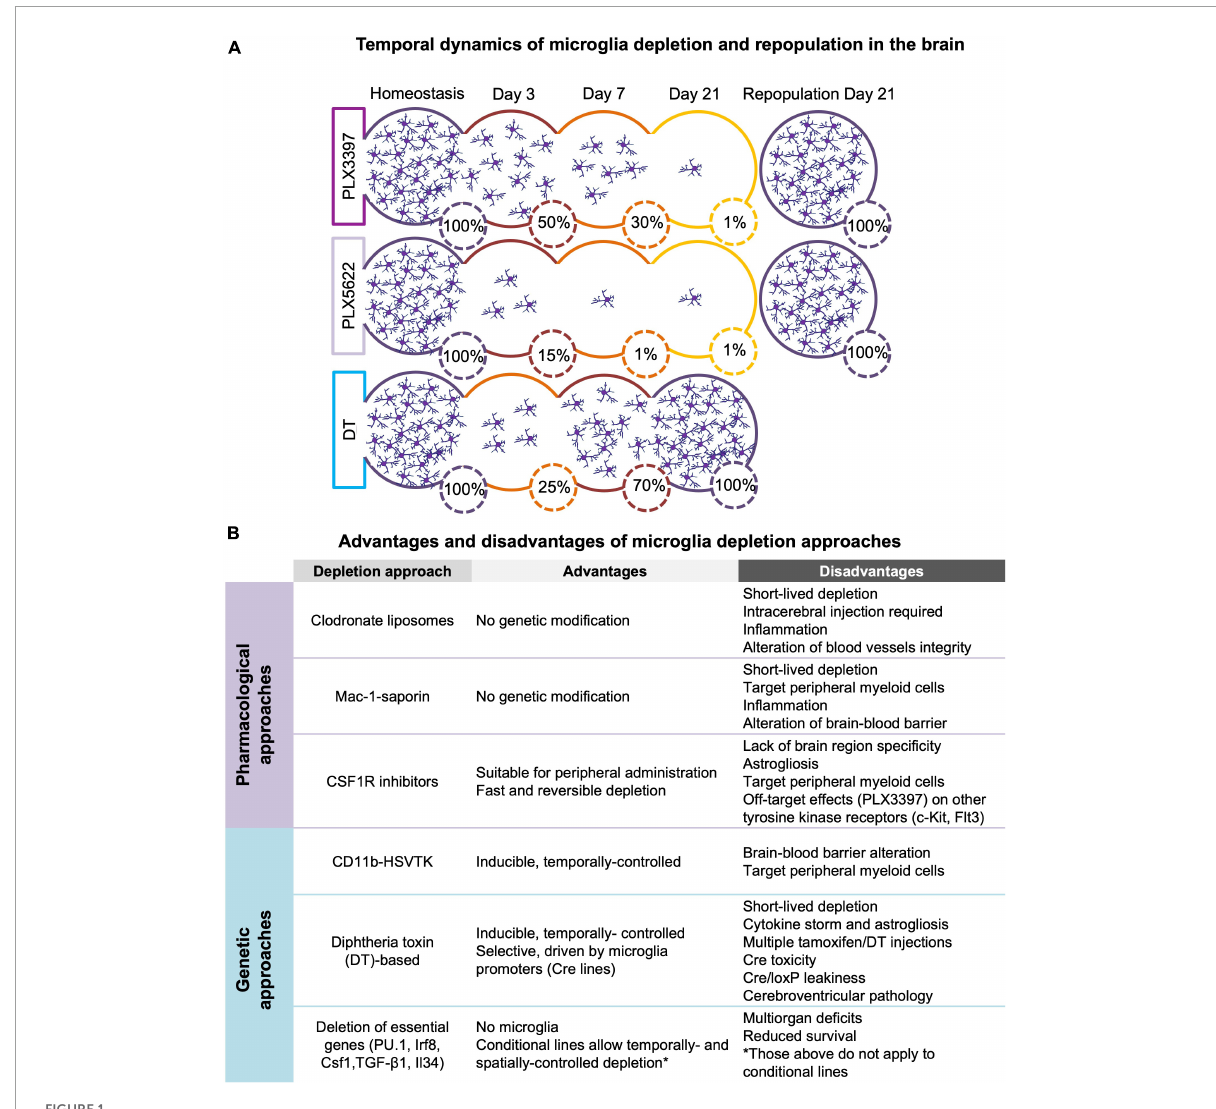
FIGURE1 (A) Temporal dynamics of microglia depletion and repopulation. Time-course of microglia depletion during administration of CSF1R inhibitors (PLX3397 and PLX5622) and repopulation upon treatment withdrawal, and time-course of genetic microglia depletion and repopulation induced by diphtheria toxin (DT) administration. Represented percentages of microglia in the brain have been extrapolated from published data (Elmore et al., 2014, 2018; Bruttger et al., 2015; Spangenberg et al., 2019; Basilico et al., 2021). (B) Advantages and disadvantages of microglia depletion methods. Summary of the main advantages and disadvantages of the different approaches used to deplete microglia (see section 2 for more